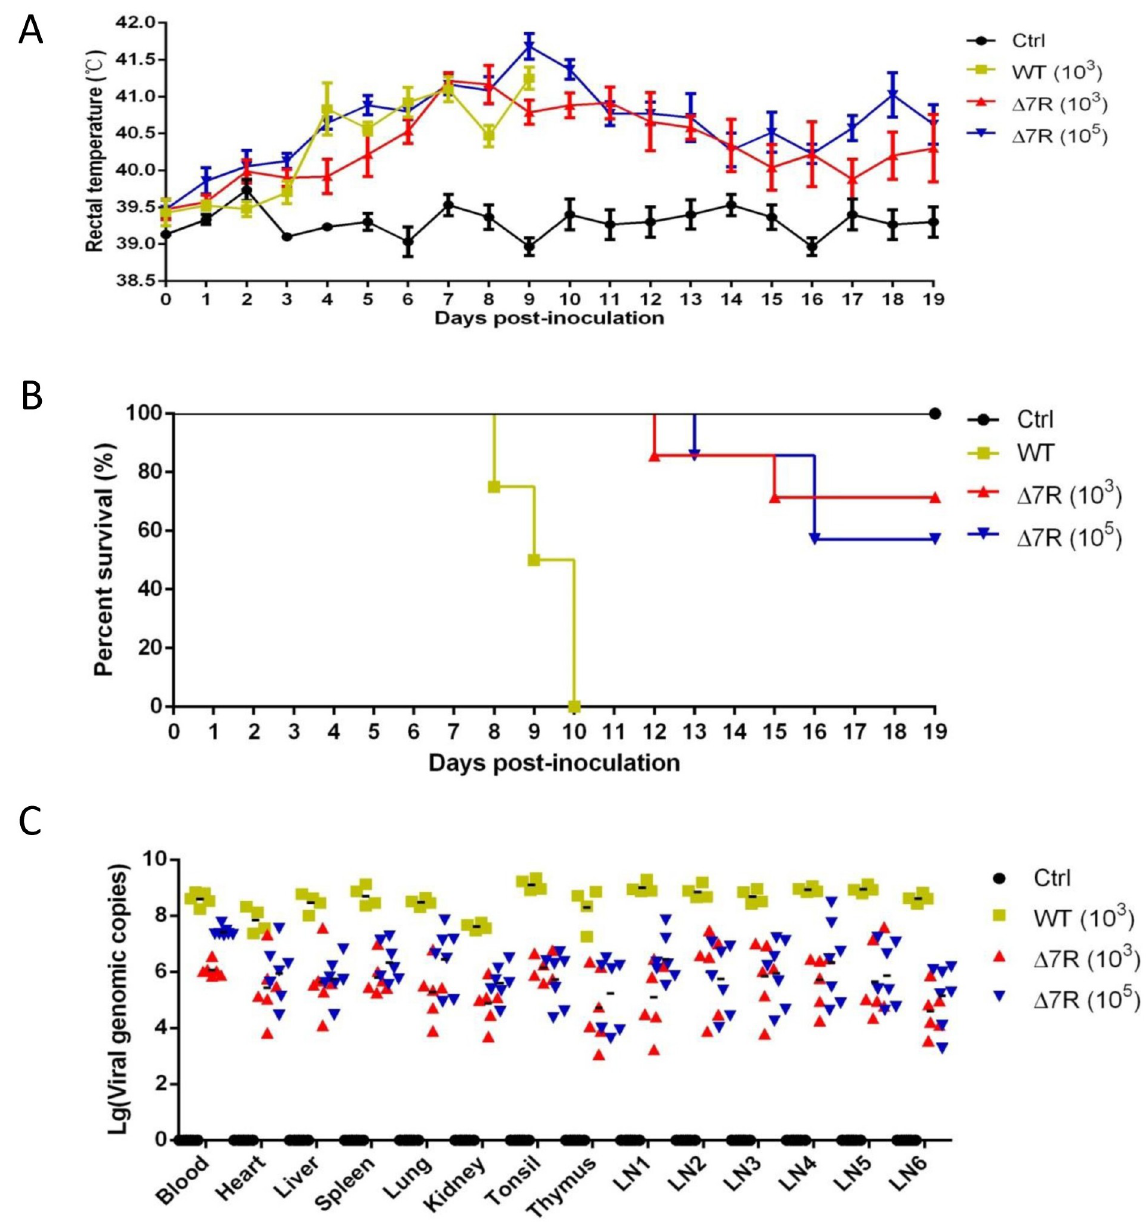
Fig 9. Deletion of MGF505-7R attenuates ASFV virulence in pigs. (A-C) The rectal temperature measurements (A) and survival rates (B) for the different groups of pigs unchallenged (Ctrl, n = 4), or challenged with 10 3 HAD 50 of parental ASFV-WT (WT, n = 4), 10 3 HAD 50 of ASFV- Δ 7R ( Δ 7R, n = 7) or 10 5 HAD 50 of ASFV- Δ 7R ( Δ 7R, n = 7) were recorded daily till day 19 post challenge. At day 19, the surviving pigs were euthanized, and the blood and tissues including the heart, lung, spleen, tonsil, thymus and five lymph nodes (intestinal lymph node, inguinal lymph node, submaxillary lymph node, bronchial lymph node, and gastrohepatic lymph node) were collected from all pigs for viral DNA quantification by qPCR (C) .